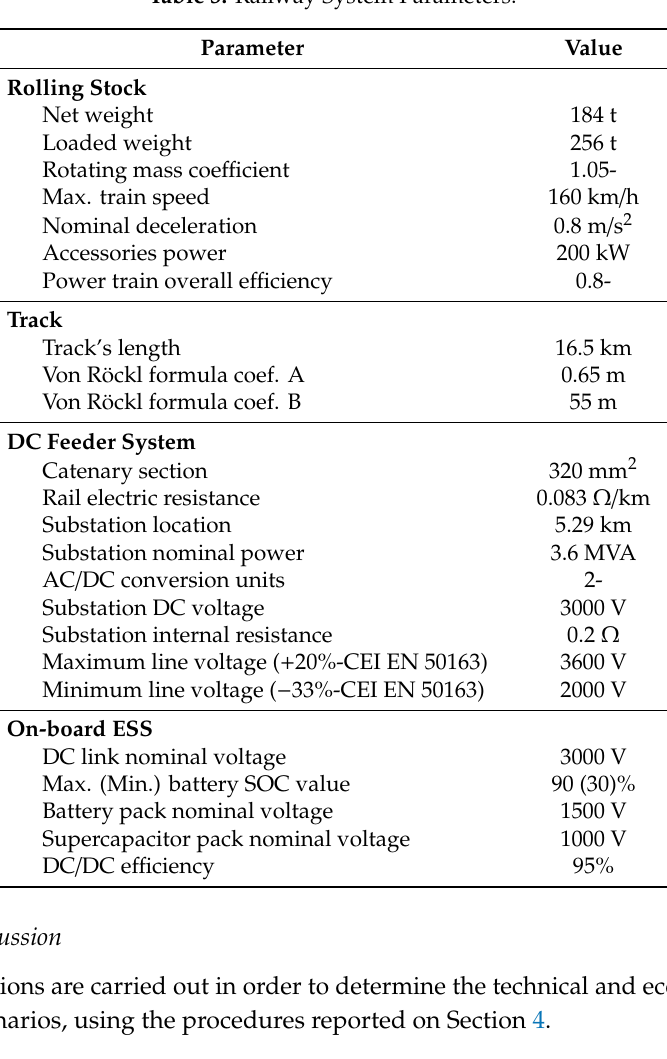
Table 3. Railway System Parameters.